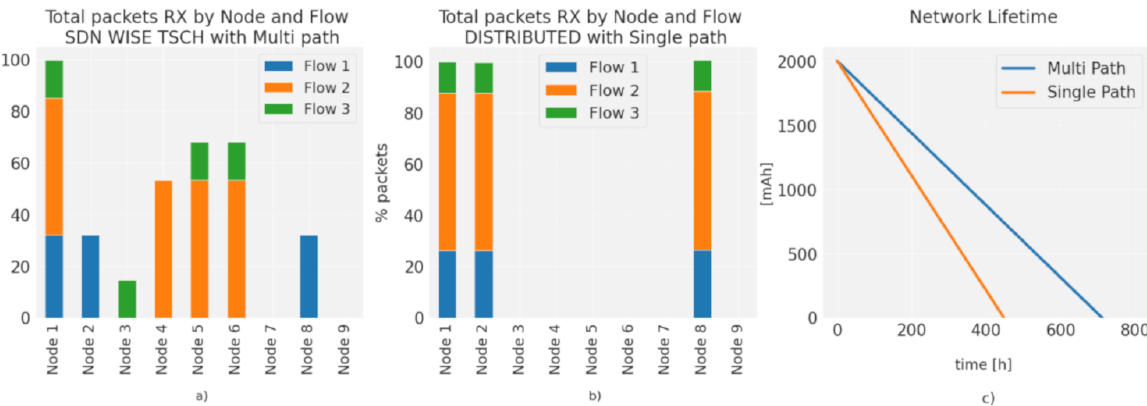
Figure 12. Distribution of flows over the nodes; ( a ) SDN WISE TSCH; ( b ) single path for all nodes; ( c ) network lifetime for